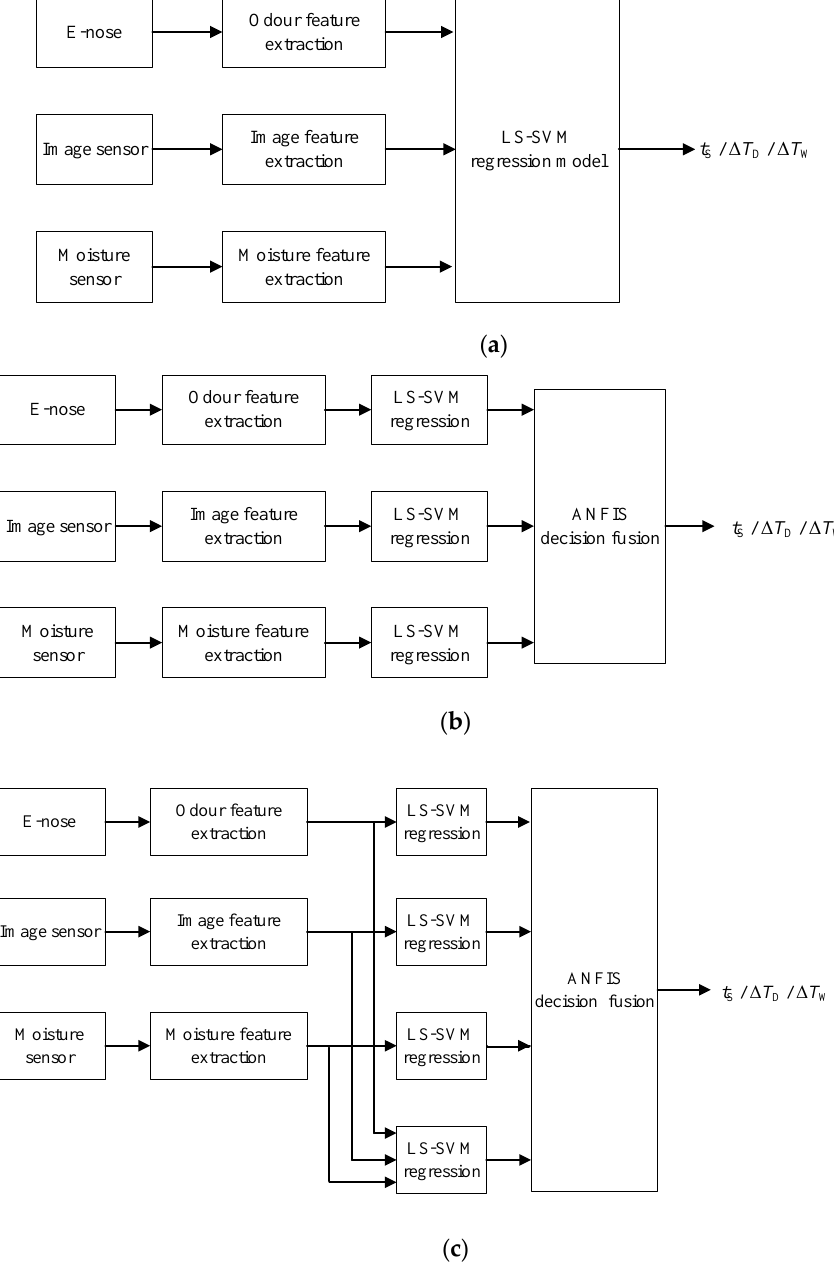
Figure 8. The proposed multi-sensor data fusion approaches are as follows: ( a ) feature level data fusion; ( b ) decision level data fusion; ( c ) hybrid multi-sensor data fusion. LS-SVM—least squares support vector machines; ANFIS—adaptive neuro-fuzzy inference system.